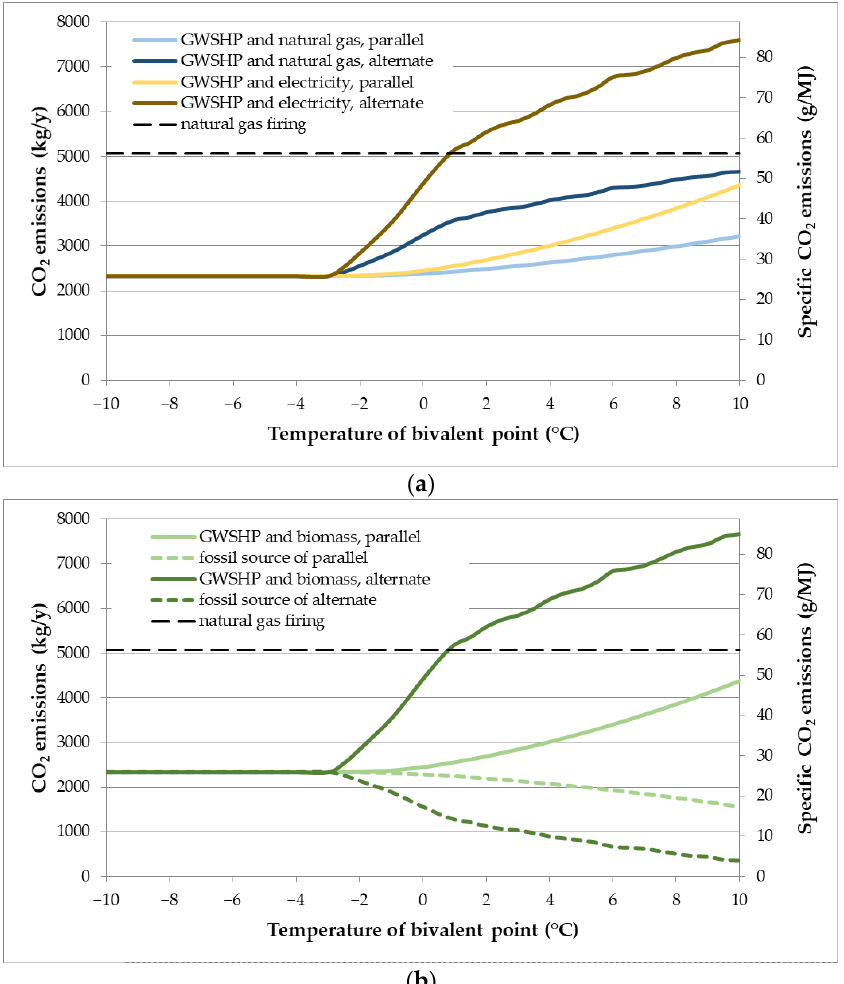
Figure 7. Annual CO 2 emissions as a function of the temperature of bivalent point in GWSHP systems: ( a ) natural gas and electricity as auxiliary heat, and ( b ) biomass as auxiliary heat.